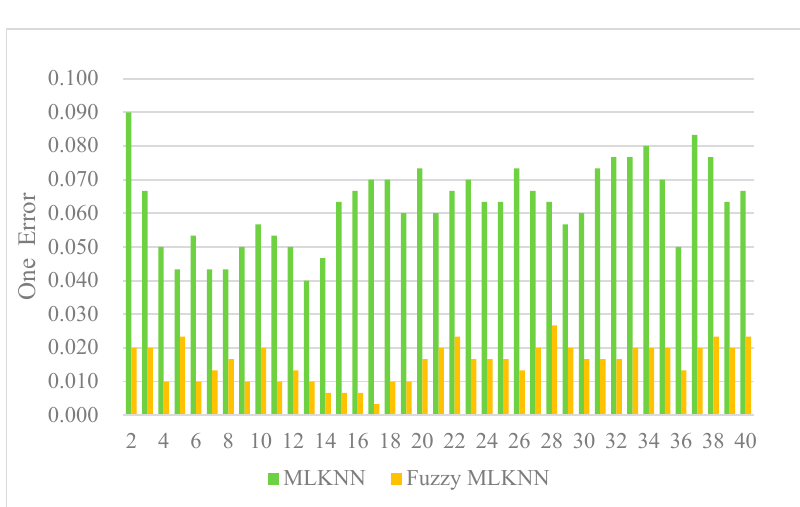
Figure 3. RankingLoss under different K values.